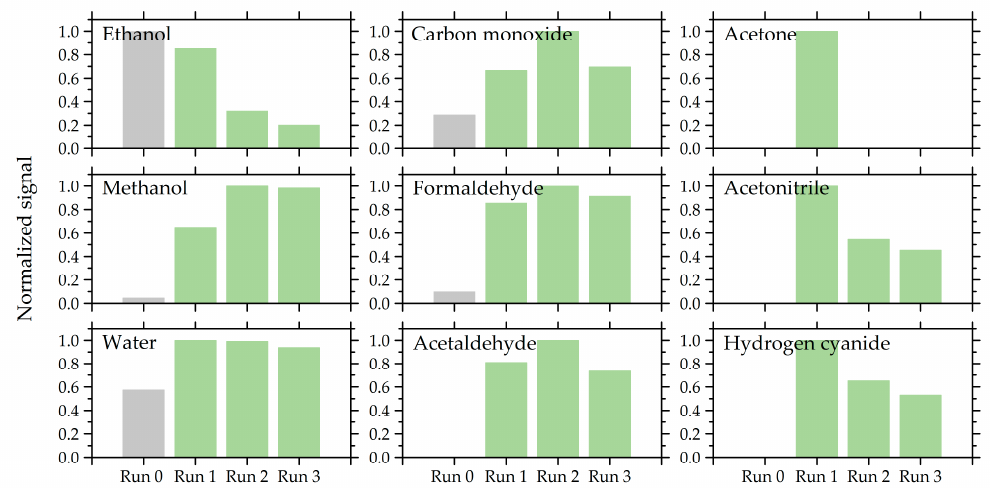
Figure 3. Variation of the amplitude between the subsequent scans of the P3 sample. Most species revealed the strongest signal in the first or second scan after heating (run 1 or run 2).